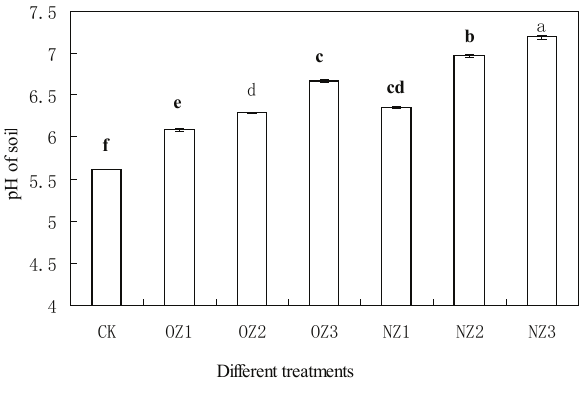
Figure 1: pH of soils in different zeolite treatments (Error bars indicate standard errors of 3 replicates. The different letters indicate significant difference at P<0.05, similarly